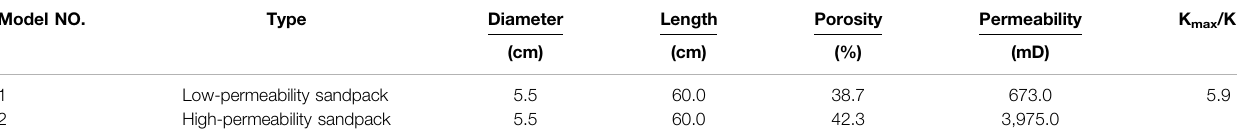
TABLE 1 | The parameters for dual-sandpacks model. Model NO.